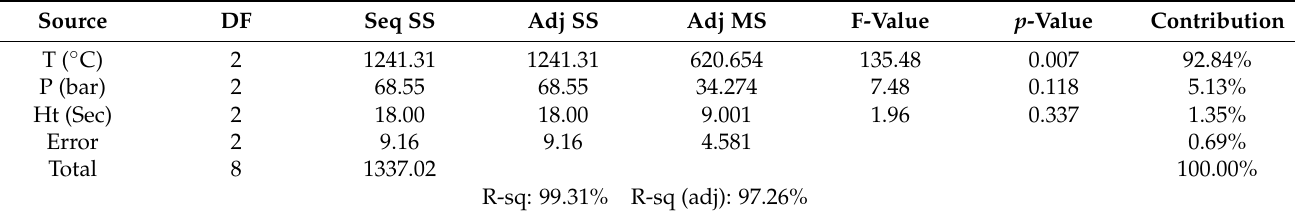
Figure 7. Main effect plots for interface thickness. Table 3. ANOVA table for interface thickness.